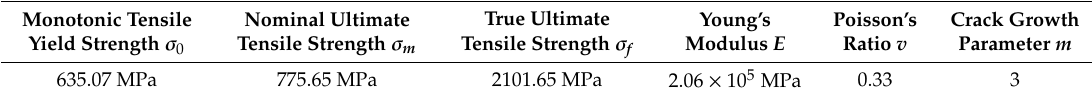
Table 1. Material parameters for steel S45.